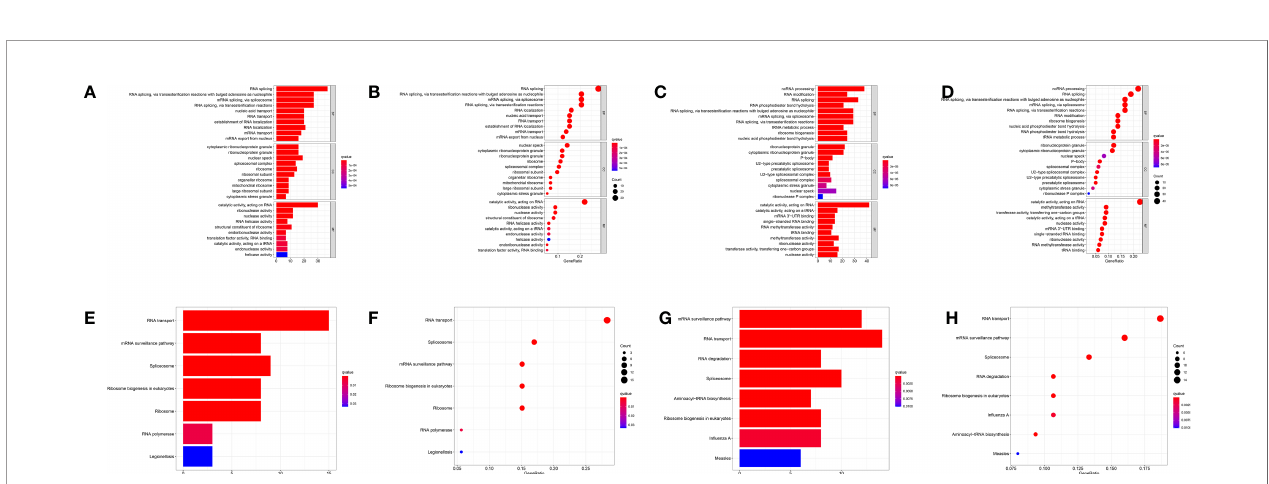
FIGURE 2 | Functional enrichment analyses for differentially expressed genes. GO enrichment analysis for down-regulated RBPs (A, B) and up-regulated RBPs (C, D) . KEGG pathways enrichment for down-regulated RBPs (E, F) and up-regulated RBPs (G, H)